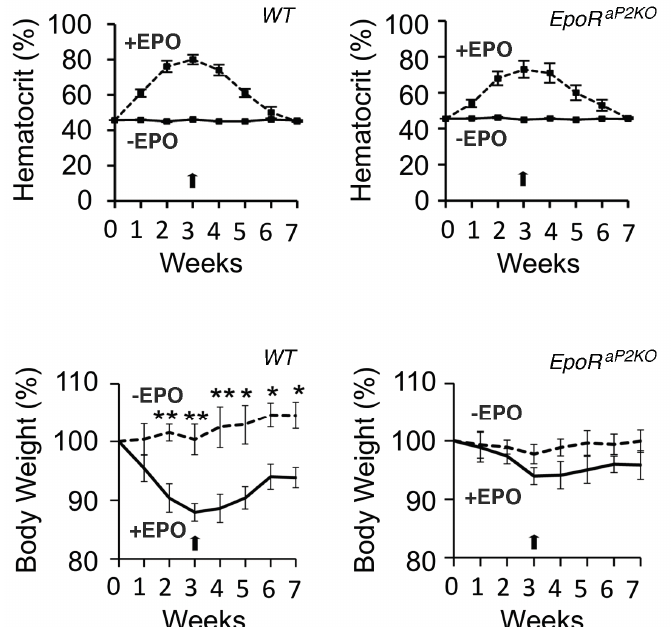
Figure 5. EPO treatment reduces body weight independent of the increased hematocrit. Left panels , wild type ( WT ) mice (C57Bl/6 background) treated with EPO for 3 weeks (3000 U/kg; 3 × weekly) show the characteristic increase in hematocrit and decrease in body weight. At the end of EPO treatment (arrow), hematocrit returns to normal by 4 weeks with a more gradual normalization of body mass; Right panels , in mice that lack EpoR in white adipose tissue ( EpoR aP2KO ) treated with EPO show the increase in hematocrit without the significant decrease in body weight, demonstrating that the change in hematocrit is not sufficient to cause the decrease in body weight and the change in fat mass requires EpoR expression in white adipose tissue. * indicates p < 0.05; ** indicates p < 0.01. Reprinted from [30] with permission. Copyright 2013